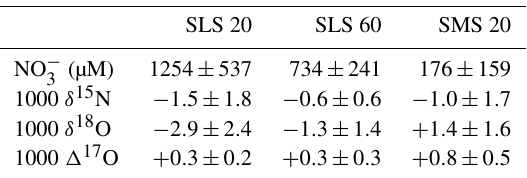
Table 2. Concentrations and isotopic compositions ( δ 15 N, δ 18 O, and (cid:49) 17 O) of soil nitrate at SLS 20, SLS 60, and SMS 20 during August to October in 2013 and 2014 (recalculated from the data in Nakagawa et al.,